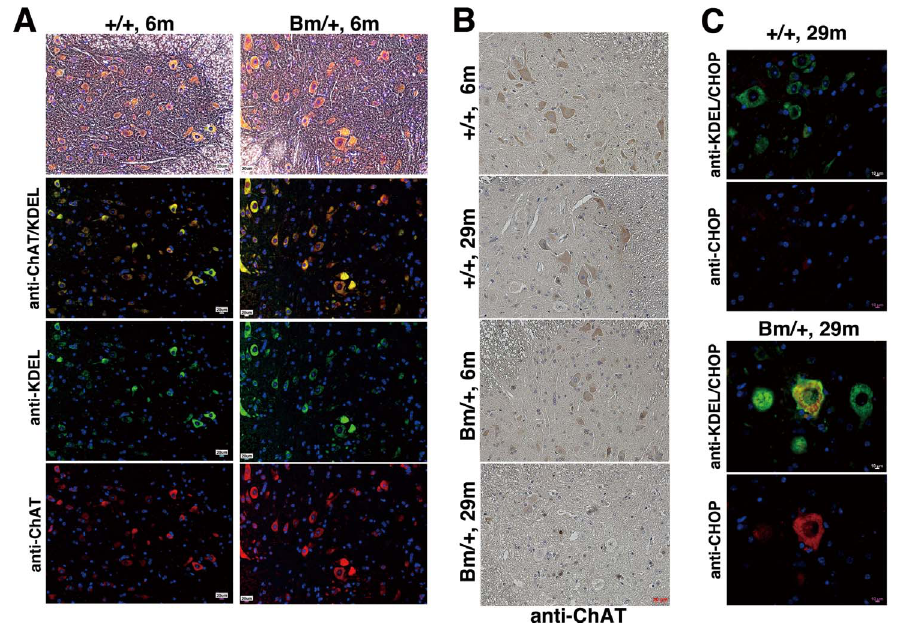
Figure 2. Motoneurons at the anterior horn of spinal cords of aged mutant BiP mice suffer from ER stress. (A) Motoneurons stained by an anti-choline acetyltransferase antibody (red) at the anterior horn in the spinal cord of both a 6 month-old wild type ( + / + , 6 m) and a 6 month-old mutant BiP mouse (Bm/ + , 6 m) express ER chaperones as well (green). Scale bars, 20 um. (B) The immunoreactivity with an anti-choline acetyltransferase antibody at the anterior horn is reduced in the aged 29 month-old mutant spinal cord (Bm/ + , 29 m). Scale bars, 20 um. (C) Large cells at the anterior horn of the aged 29 month-old mutant spinal cord (Bm/ + , 29 m) express ER chaperones as well as CHOP. Scale bars, 10 um. The nuclei were stained with Hoechst 33258 (blue, A and